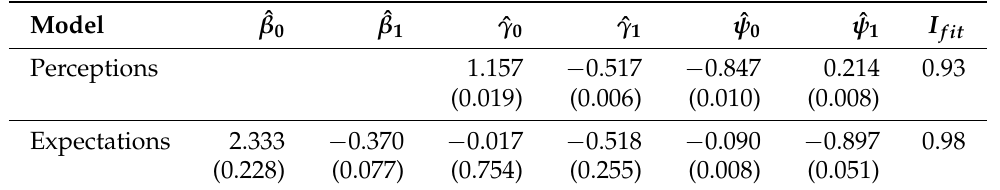
Table 1. Estimation results (standard errors in parentheses).